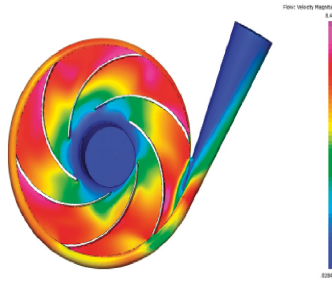
Figure 5: Velocity cloud.